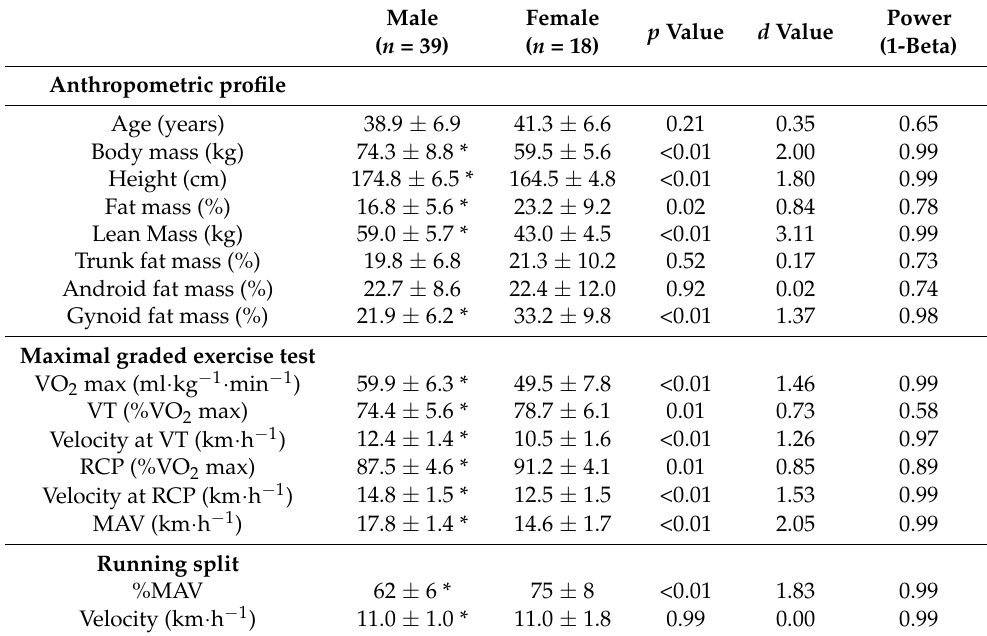
Table 2. Descriptive characteristics of the triathletes and comparison between the